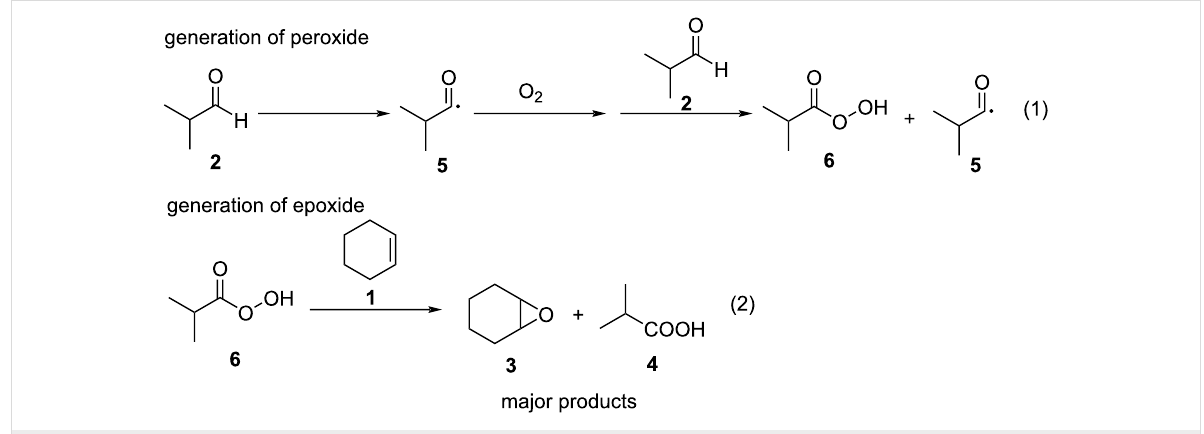
Scheme 2: Plausible reaction pathway of the epoxidation of cyclohexene with air in the flow system.